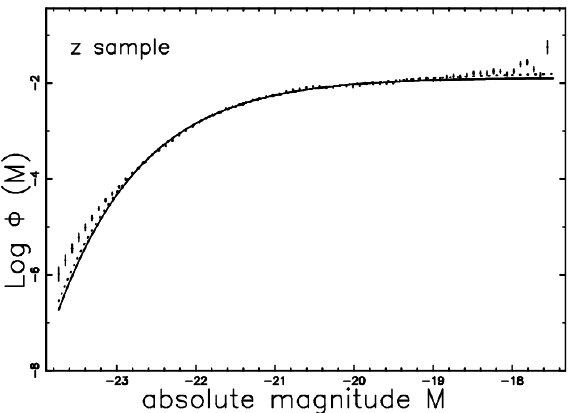
Figure 8. The luminosity function data of the Sloan Digital Sky Survey (SDSS) ( z (cid:6) ) are represented with error bars. The continuous line fit represents our truncated gamma luminosity function (LF) (44) with parameters M l = line represents the Schechter LF with parameters Φ (cid:6)